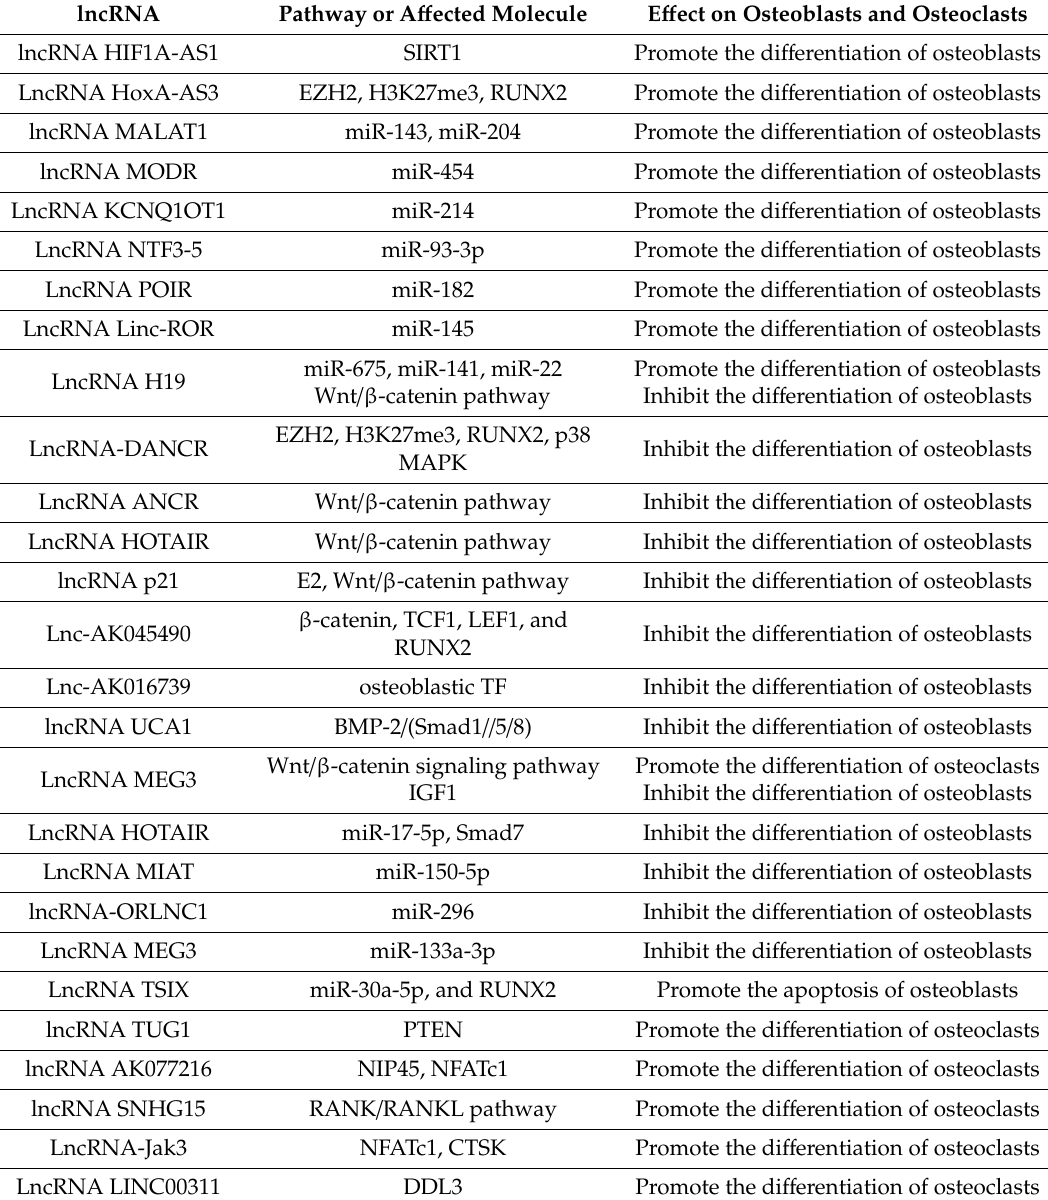
Table 4. The pathway / a ff ected molecule or lncRNAs and their e ff ects in bone biology. lncRNA Pathway or A ff ected Molecule E ff ect on Osteoblasts and